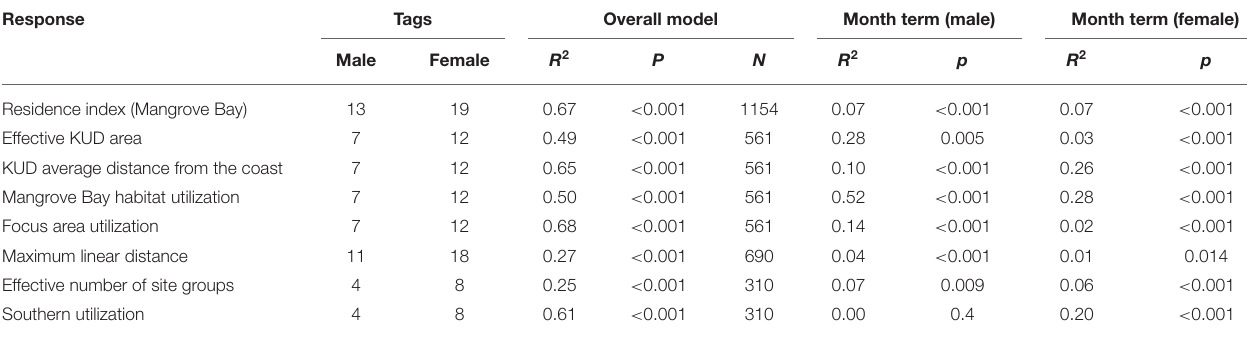
TABLE 2 | Generalized additive models of seasonal